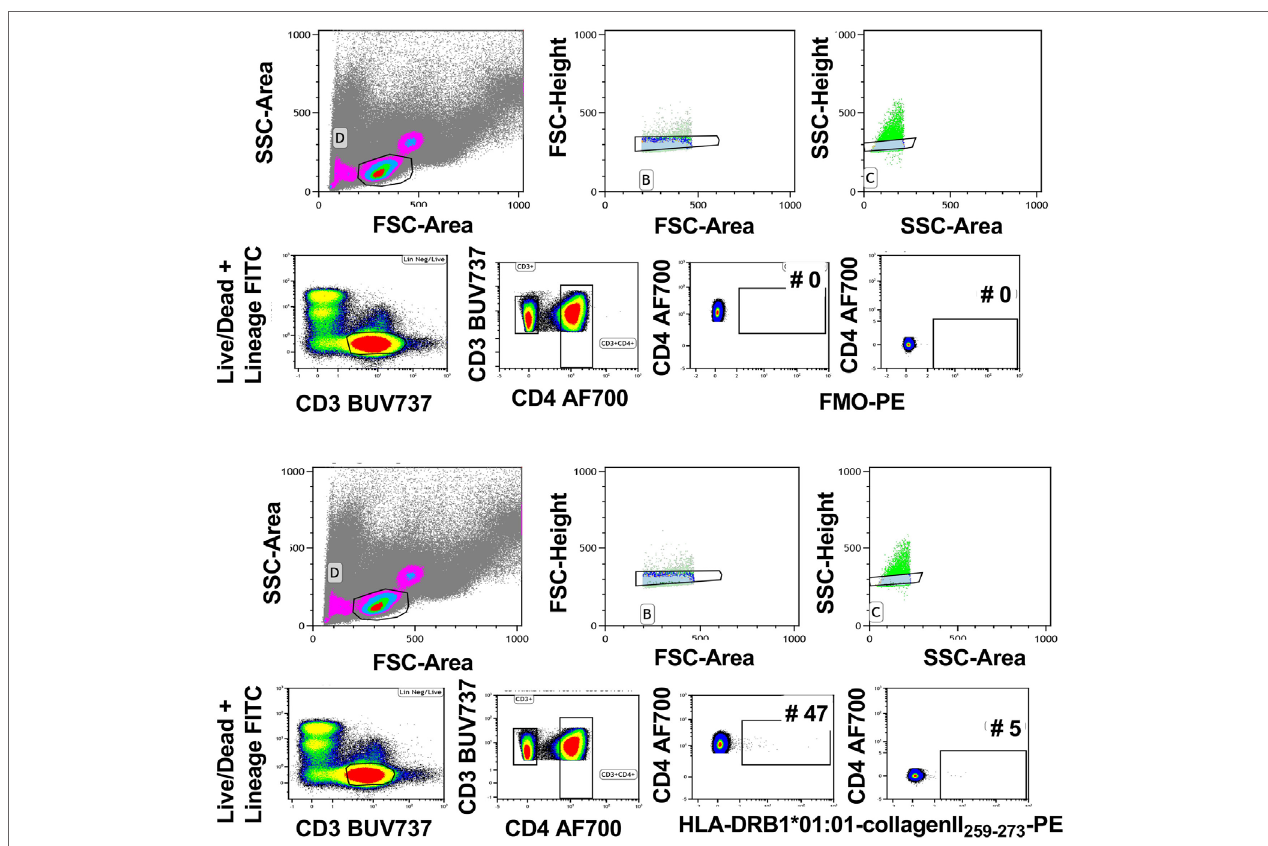
FIgURe 3 | Gating strategy for tetramer analysis. Live cells were gated using forward and side scatter. Subsequently, single cells were gated using forward scatter height and area followed by side scatter height and area (upper panels). Live CD3 + cells were gated using Lineage/LIVE/DEAD marker negative and CD3-positive cells. Next, CD4 + T cells were gated by gating on the CD3 + CD4 + double-positive cells. The FMO sample was used to determine the tetramer-positive gate. The gate was set on the CD4-postive cells that are negative in the tetramer channel (middle panels). This gate was used to identify the CD4 + tetramer + cells in the rest of the samples (bottom panels). Representative of 40